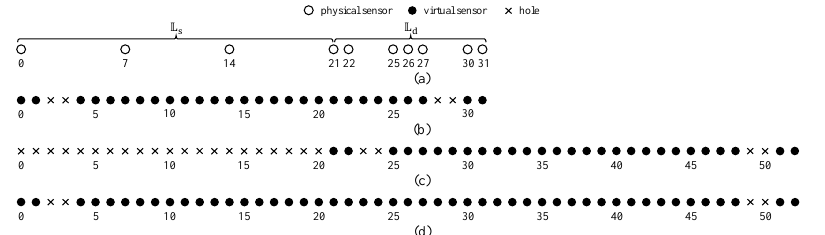
Figure 2. An example of transformed nested array that satisfies the remainder constraint, where N 1 = 4, N 2 = 6. ( a ) Physical array. ( b ) Cross-difference set L d − L s . ( c ) Cross-sum set L d + L s . ( d ) ( L d − L s ) ∪ ( L d + L s )